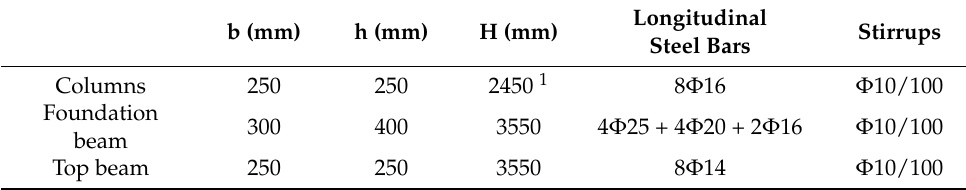
Figure 1. ( a ) Dimensions of the RC frame and detailing of the internal steel reinforcement and ( b ) specimen A2R with FRPU jacket on the infill surfaces. Table 1. The dimensions of the RC frame and the detailing of the internal steel reinforcement.